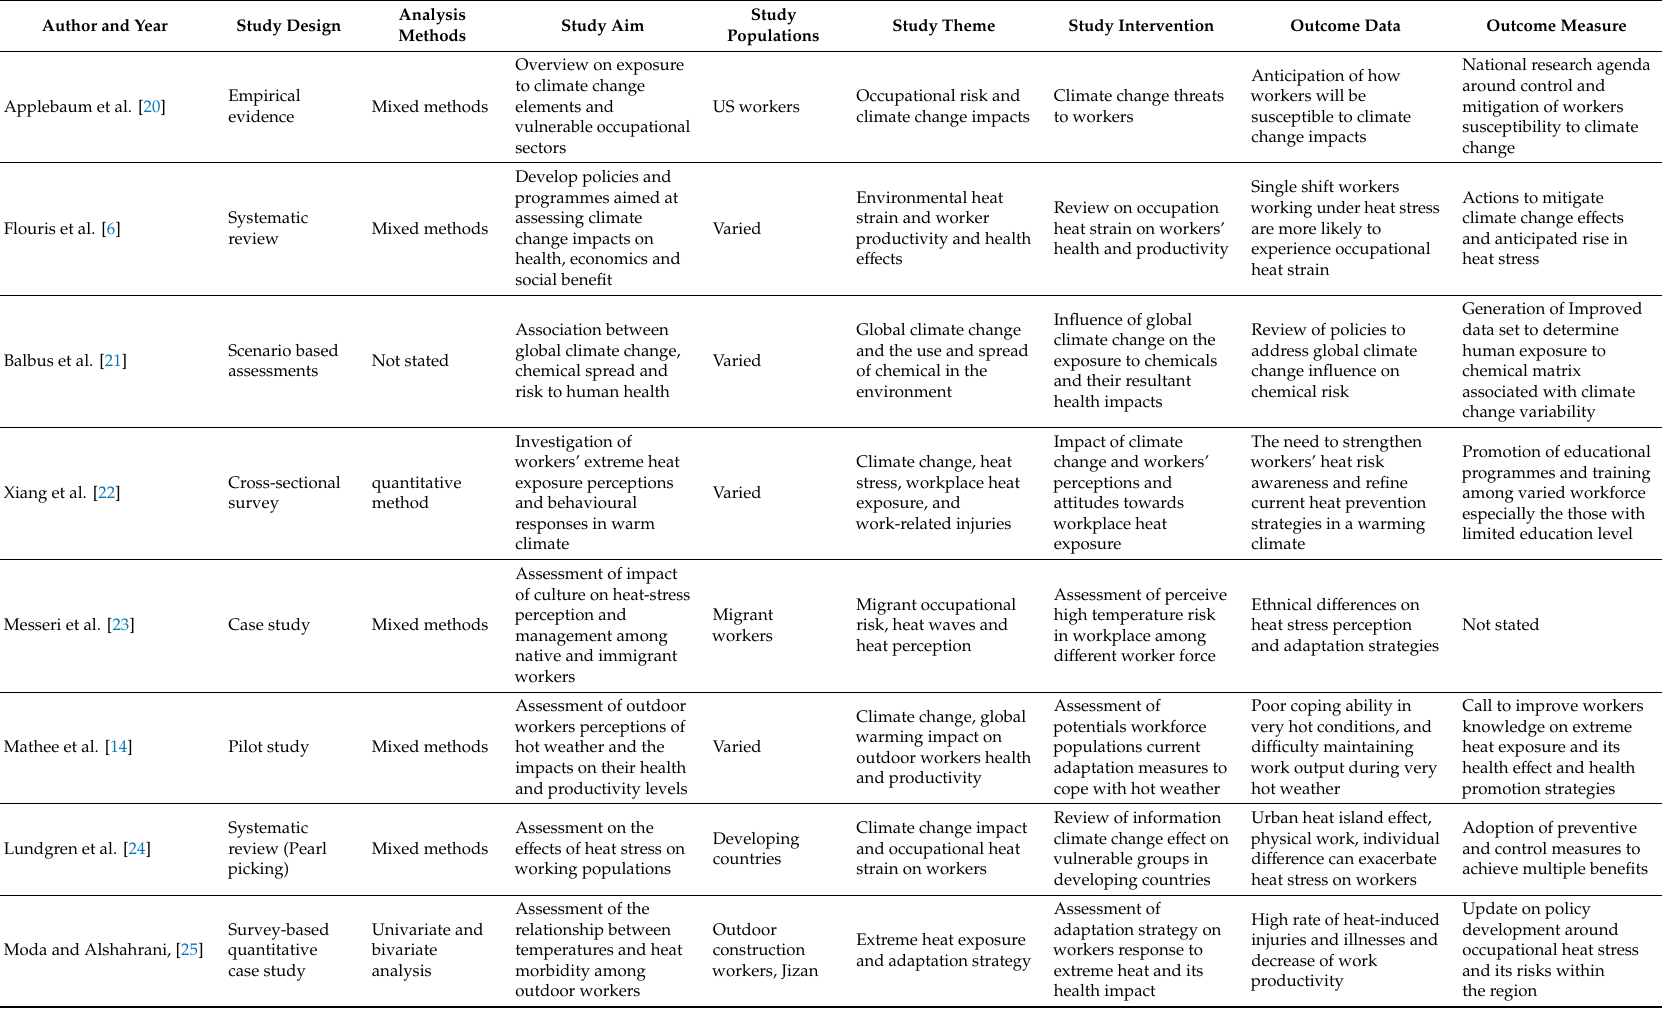
Table 2. Characteristics of the materials included in the